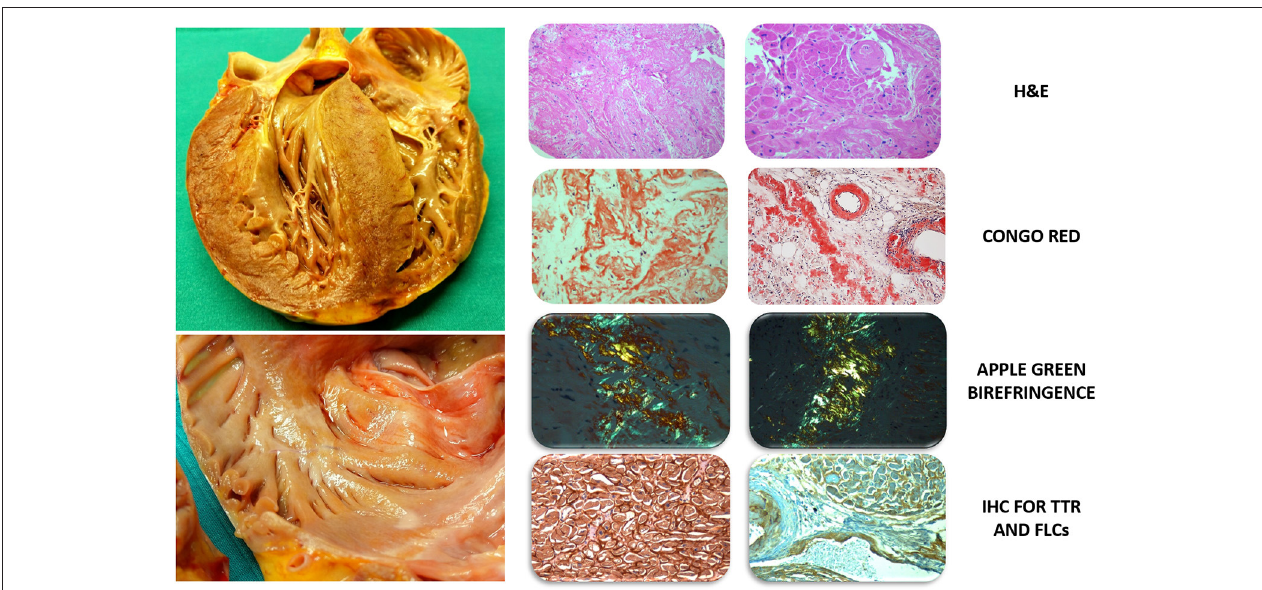
FIGURE 1 | Gross evaluation of unfixed heart and histological characterization with dedicated staining. Left Top: massive cardiac hypertrophy of the left ventricle involving the subvalvular aortic region extending to the right ventricle, the papillary muscles and the inter-atrial septum. The heart exhibits a heterogeneous color with pale areas and faint yellowish tone. Bottom: increased atrial wall thickness with diffuse granulations on the endocardial surface and nodular deposits of amyloid. Right: left column (optical field 10 × ) and right column (optical field 20 × ): H&E , severe amyloid infiltration in the interstitium and vessels with degeneration of myocytes; Congo Red and polarized light microscope , Congo Red binding to amyloid fibrils showing the typical apple-green birefringence and revealing predominant interstitial infiltration; amyloid infiltration involves the interstitial space and vessel walls, including the sinoatrial nodal artery; IHC for TTR and FLCs, positivity of transthyretin (left, 40 × ) and immunoglobulin light chain Kappa (right, 20 × ) in advanced cases of cardiac amyloidosis. H&E, Hematoxylin and Eosin; FLCs, Free Light Chains; IHC, Immunohistochemistry; TTR,